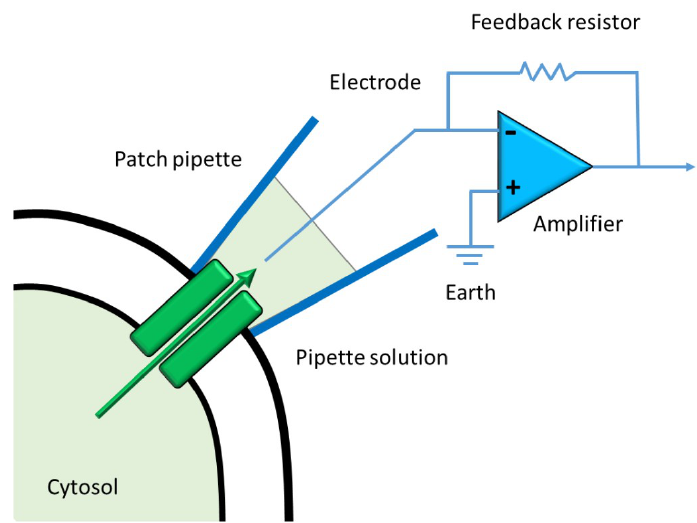
Figure 2. General principle of patch-clamp recording. A glass pipette containing electrolyte solution is seeded onto the cell membrane, isolating a membrane patch electrically. Currents are recorded by an electrode connected to highly sensitive amplifier.